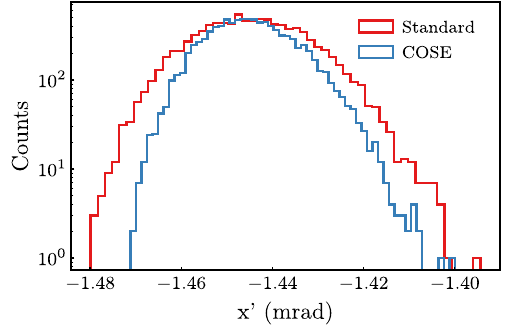
FIG. 6. Angular distribution at the location of the ES wires for COSE (red, σ ¼ 9 . 8 μ rad) and tune sweep (Standard, blue; σ ¼ 12 . 3 μ